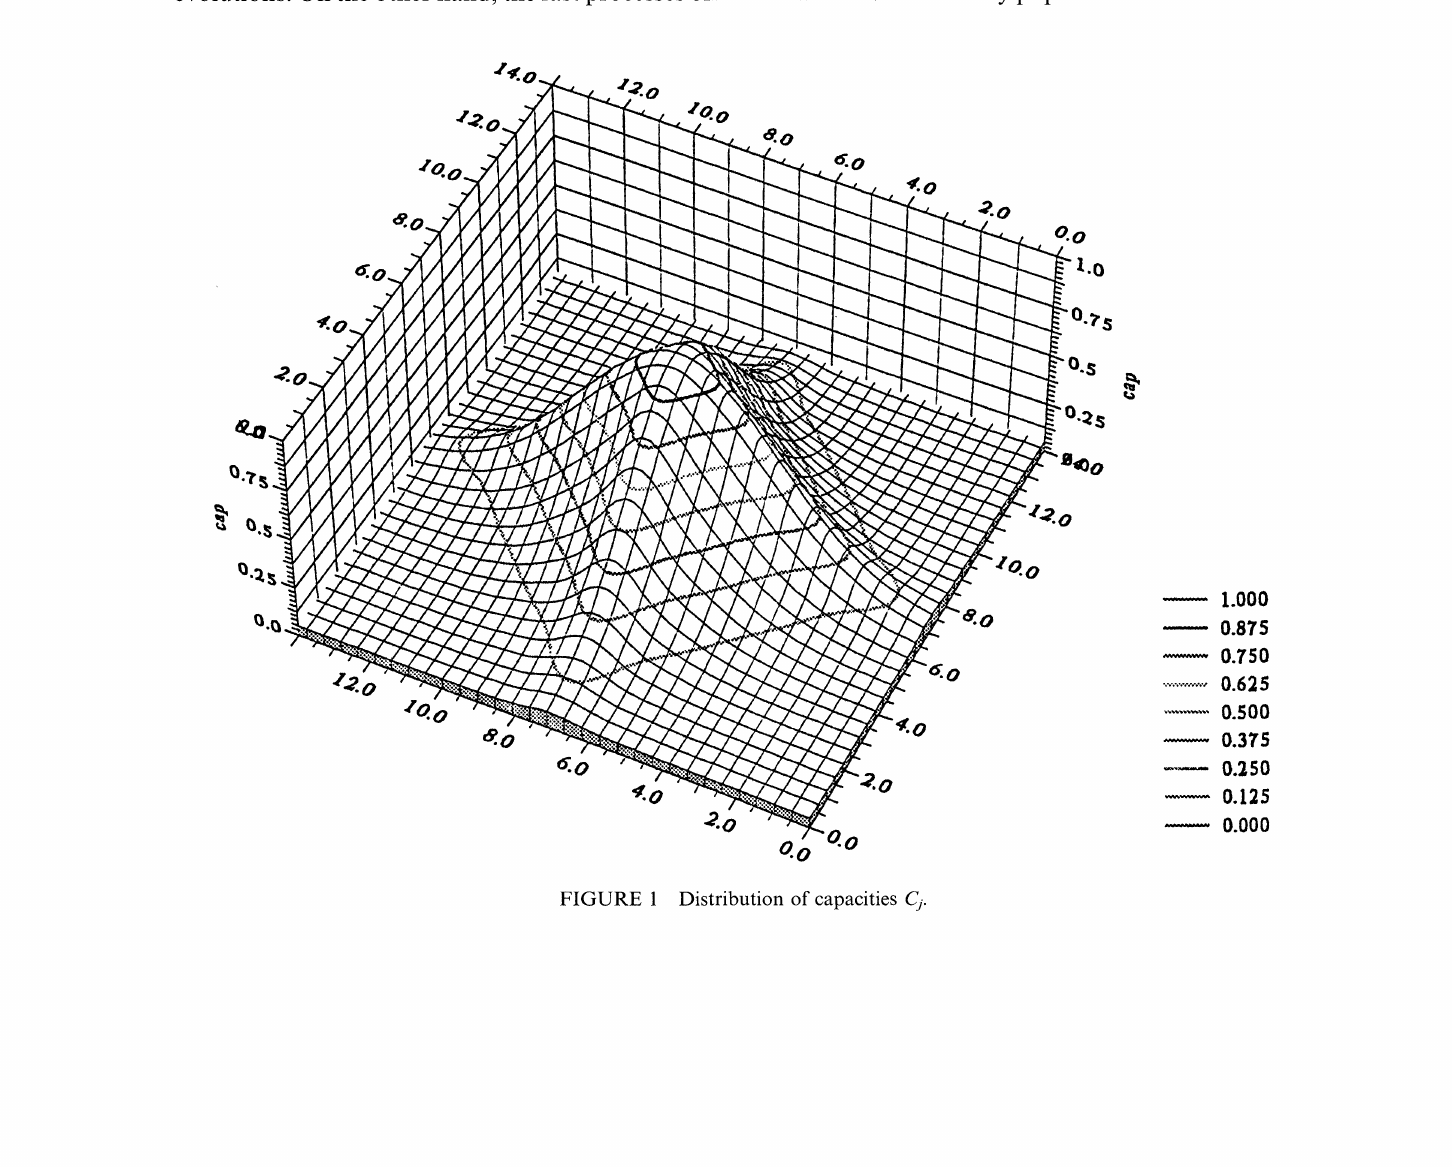
FIGURE Distribution of capacities